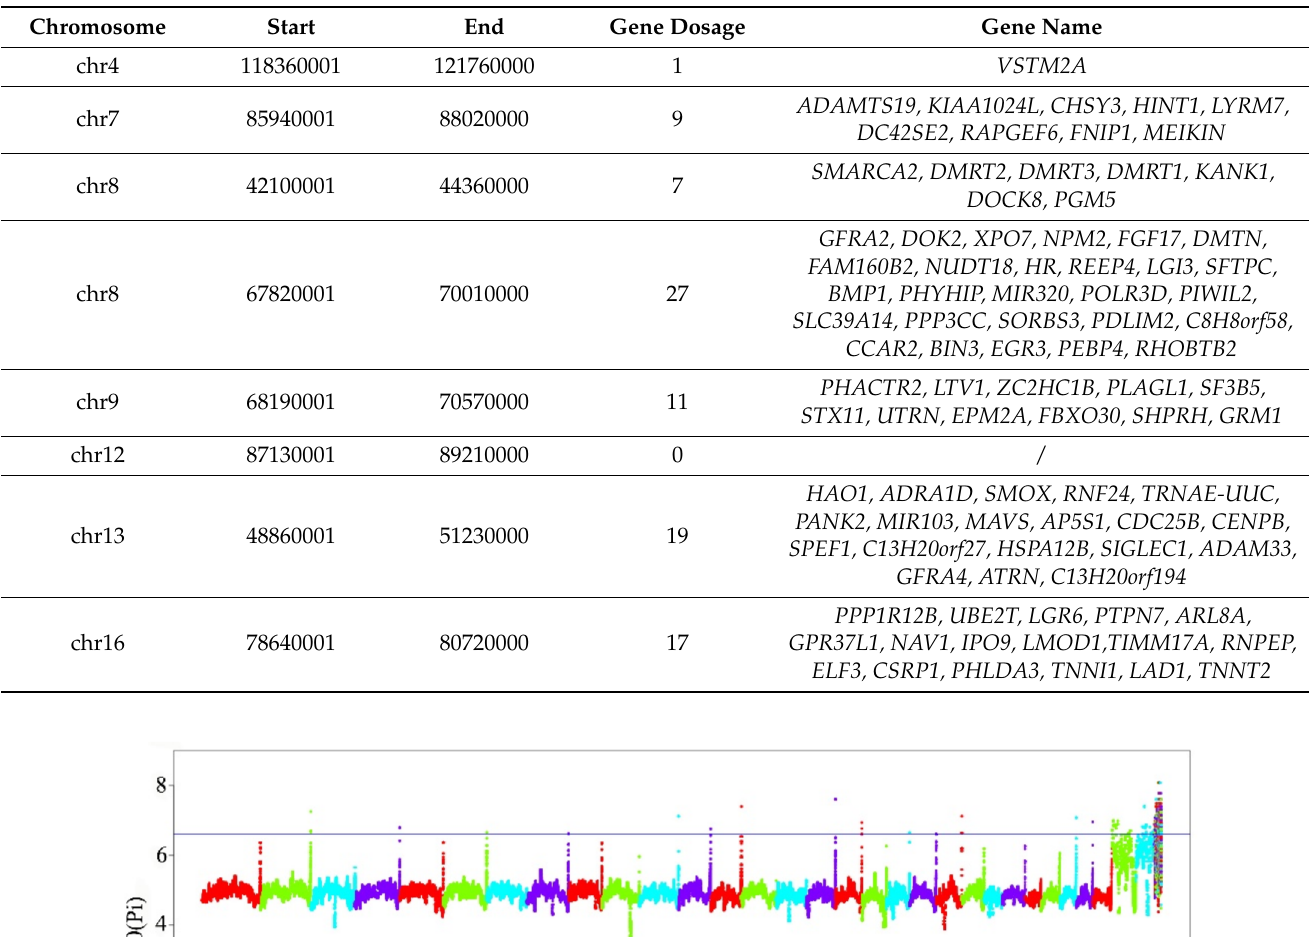
Table 1. Information on the common set of selected fragments and genes identified based on F ST and π methods.